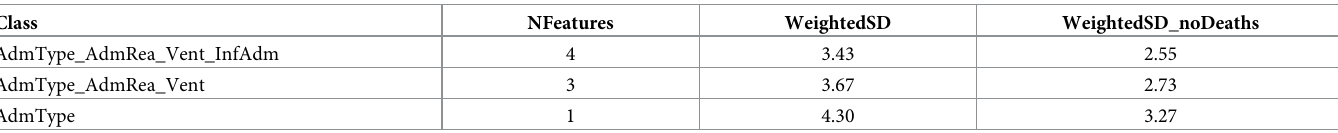
Table 2. Classification quality—With and without